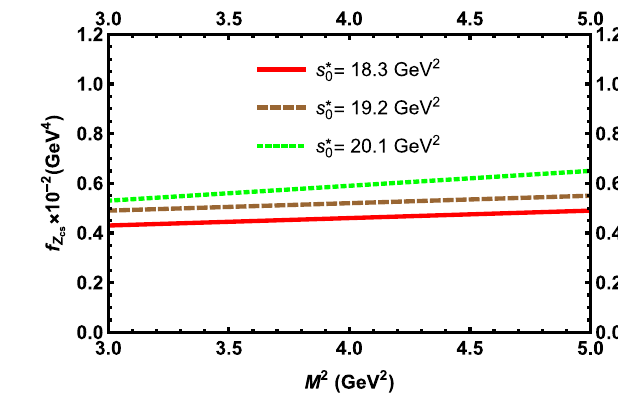
Fig. 1 The vacuum mass of Z cs state as function of M 2 at different fixed values of continuum threshold